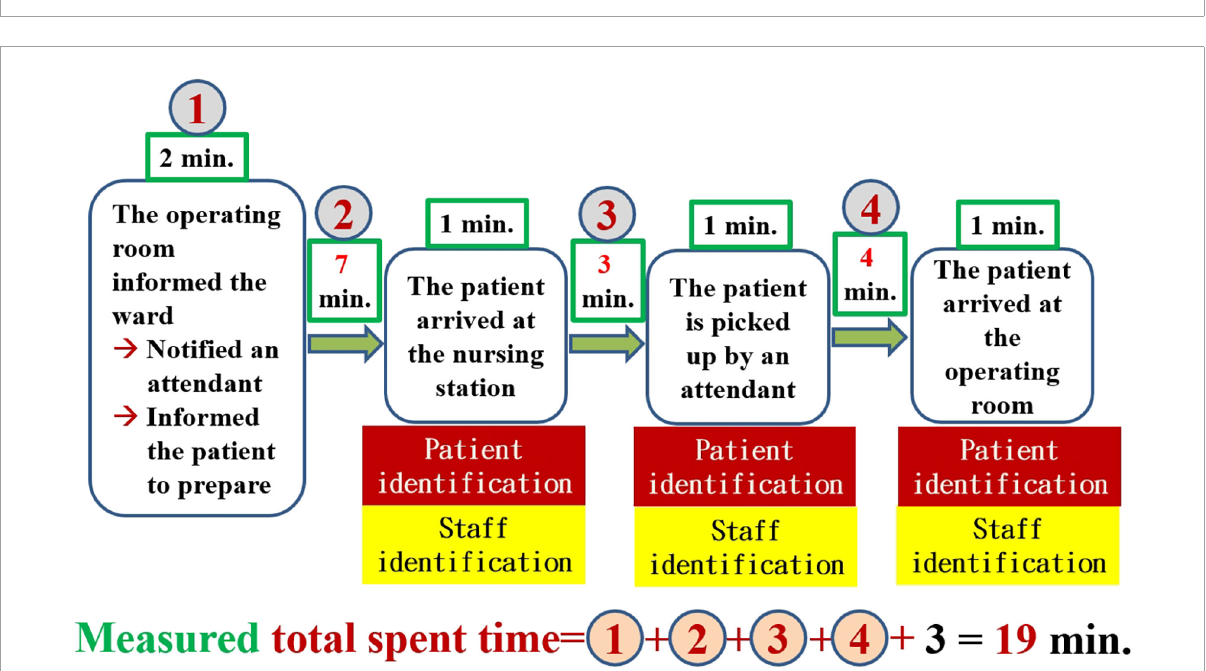
FIGURE10 The future process based on computer information-assisted patient/staff identification with time